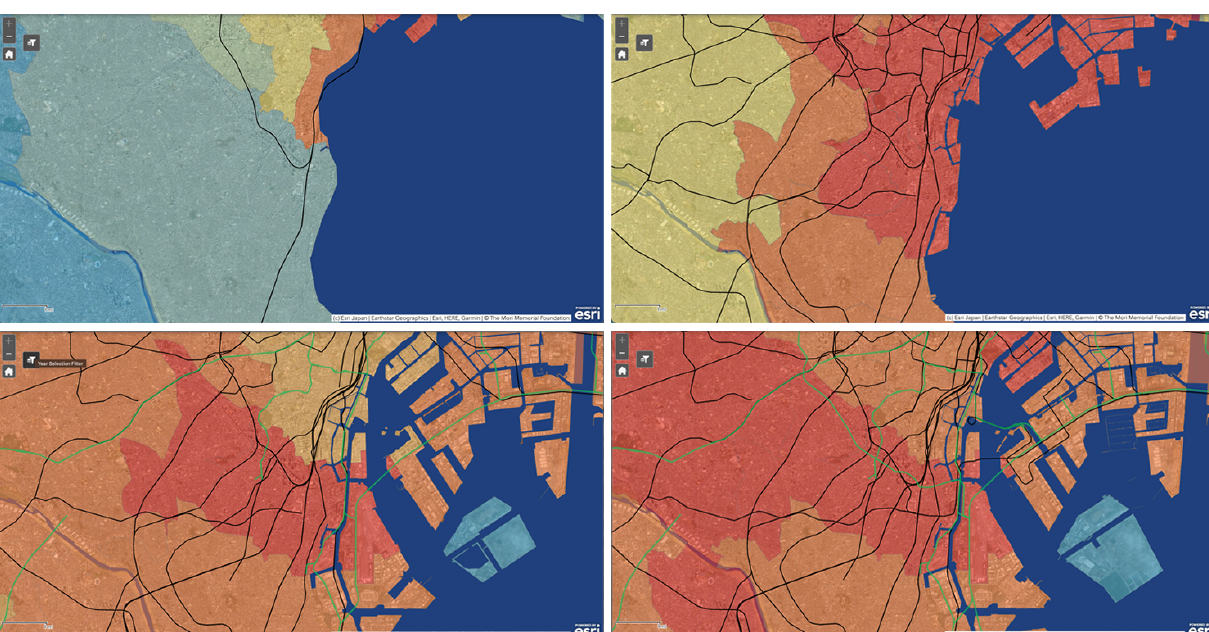
Figure 7. Population density (persons/ha) in 1890 (7.68), 1940 (198.4), 1990 (152.45) and 2015 (171.0). Source: Institute for Urban Strategies (2020).